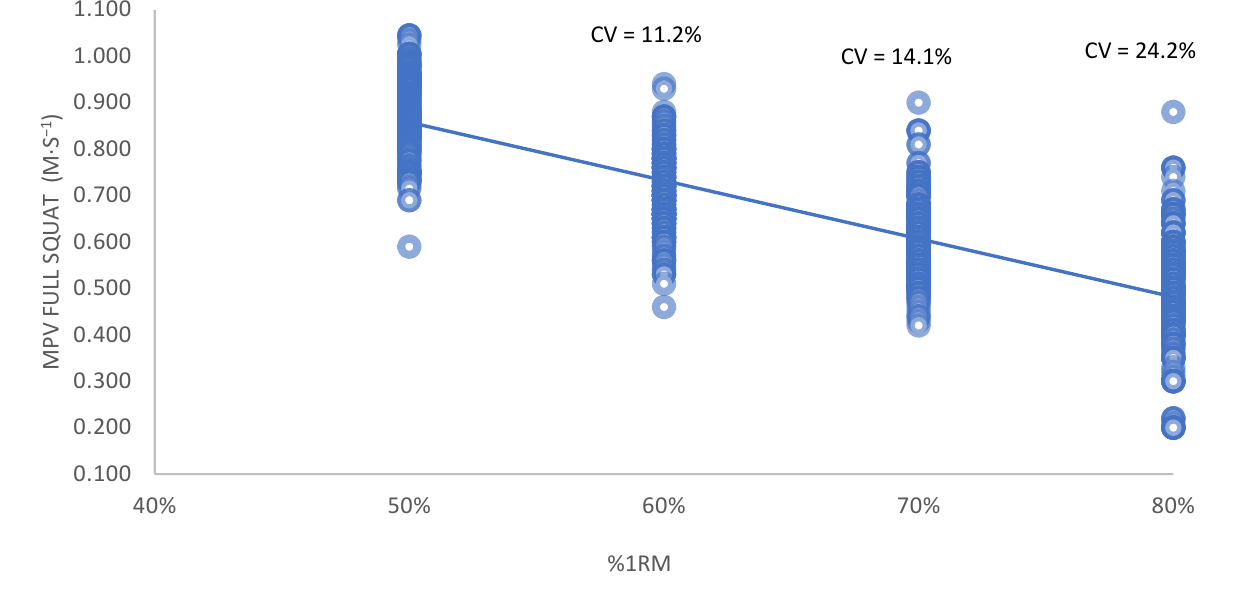
Table 2. Maximum and minimum values and coefficient of variation of the MPV at the different percentages of 1RM in the bench press and full squat.